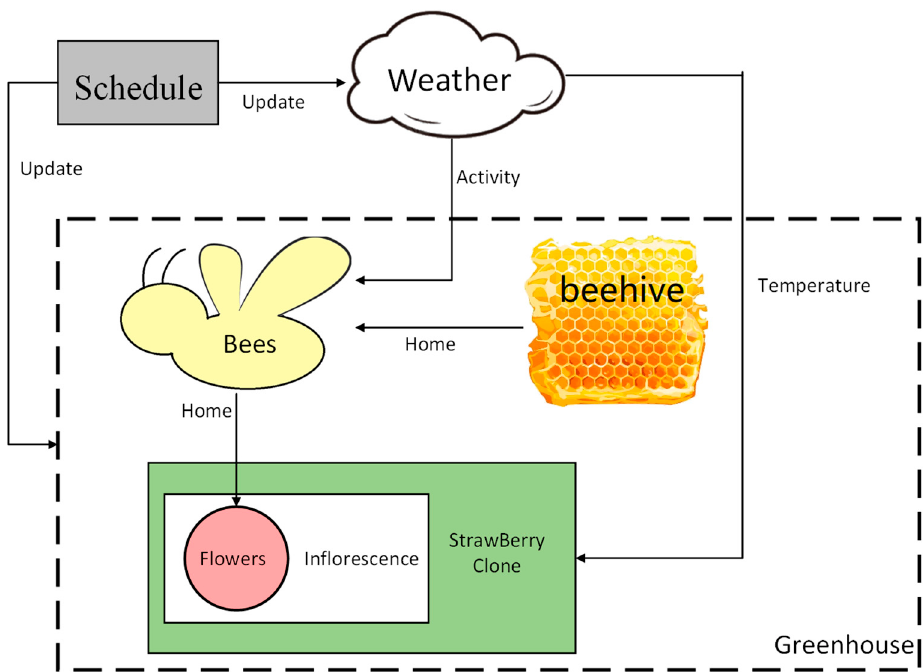
Figure 1. Entities and their interactions for strawberry pollination.